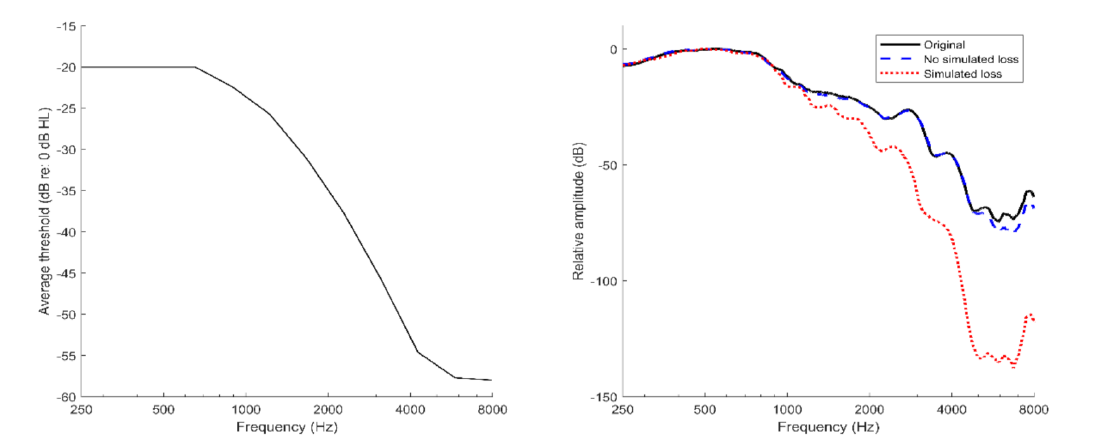
Figure 1. Average simulated hearing loss based on the older adult data from Morgan and Ferguson [9] (left) and the long-term average speech spectrum of 30 s samples of concatenated stimuli from the original unprocessed stimuli, the stimuli processed with no simulated loss, and the stimuli processed with the simulated hearing